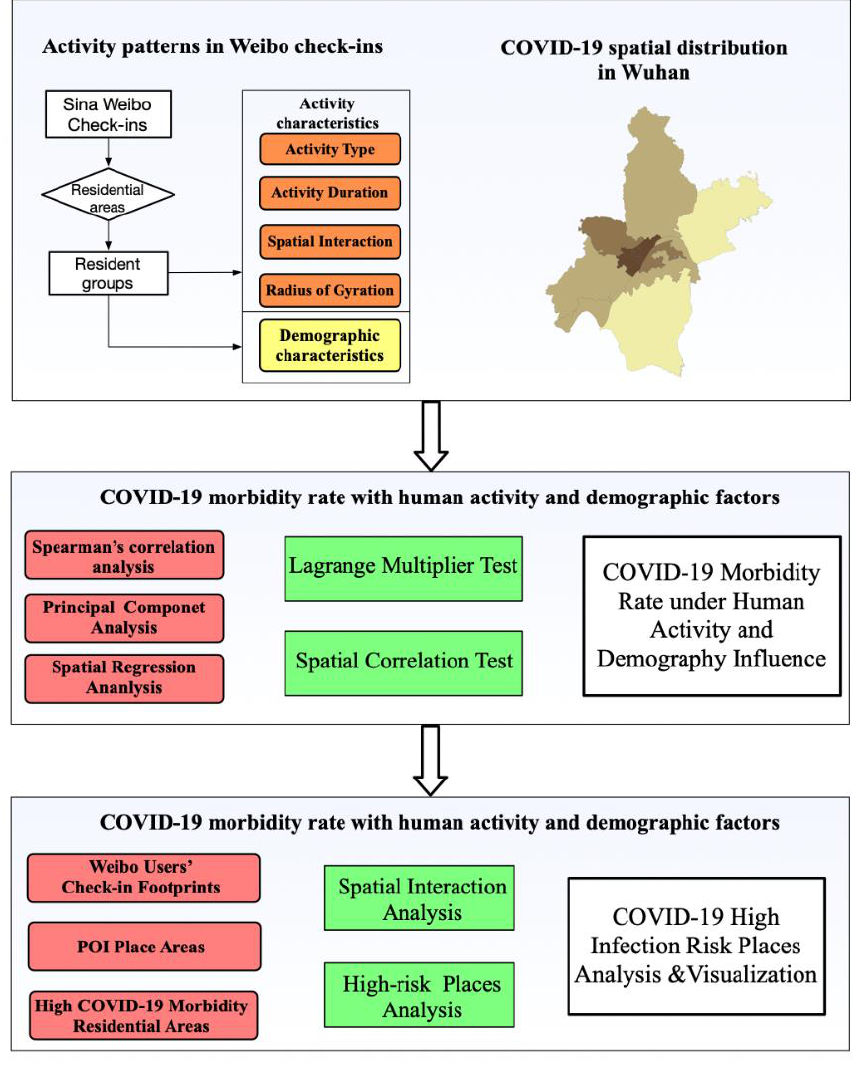
Figure 2. Study design.